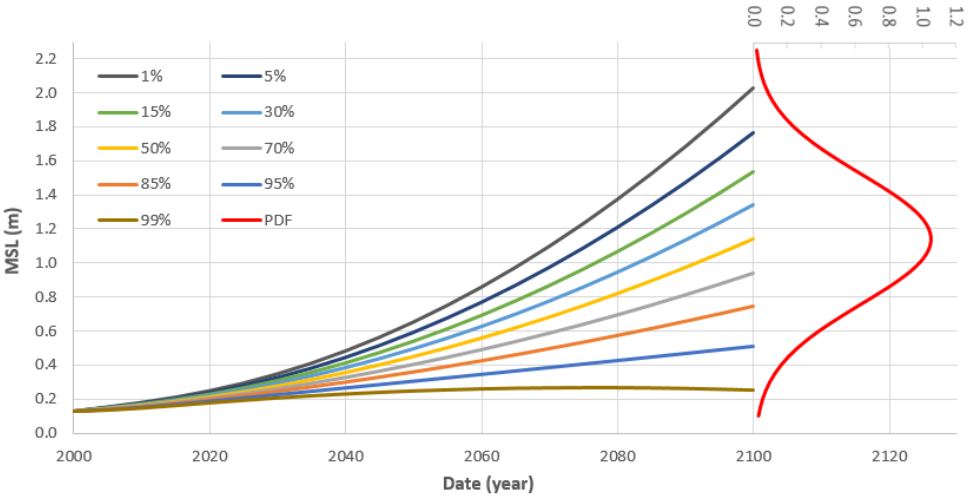
Figure 11. Relative SLR projections (in meters) for the 21st century of the WCPM, corresponding to a discrete set of percentiles, from 1 to 99% (probability of not being exceeded). The PDF curve is fitted to the MSL y -axis.